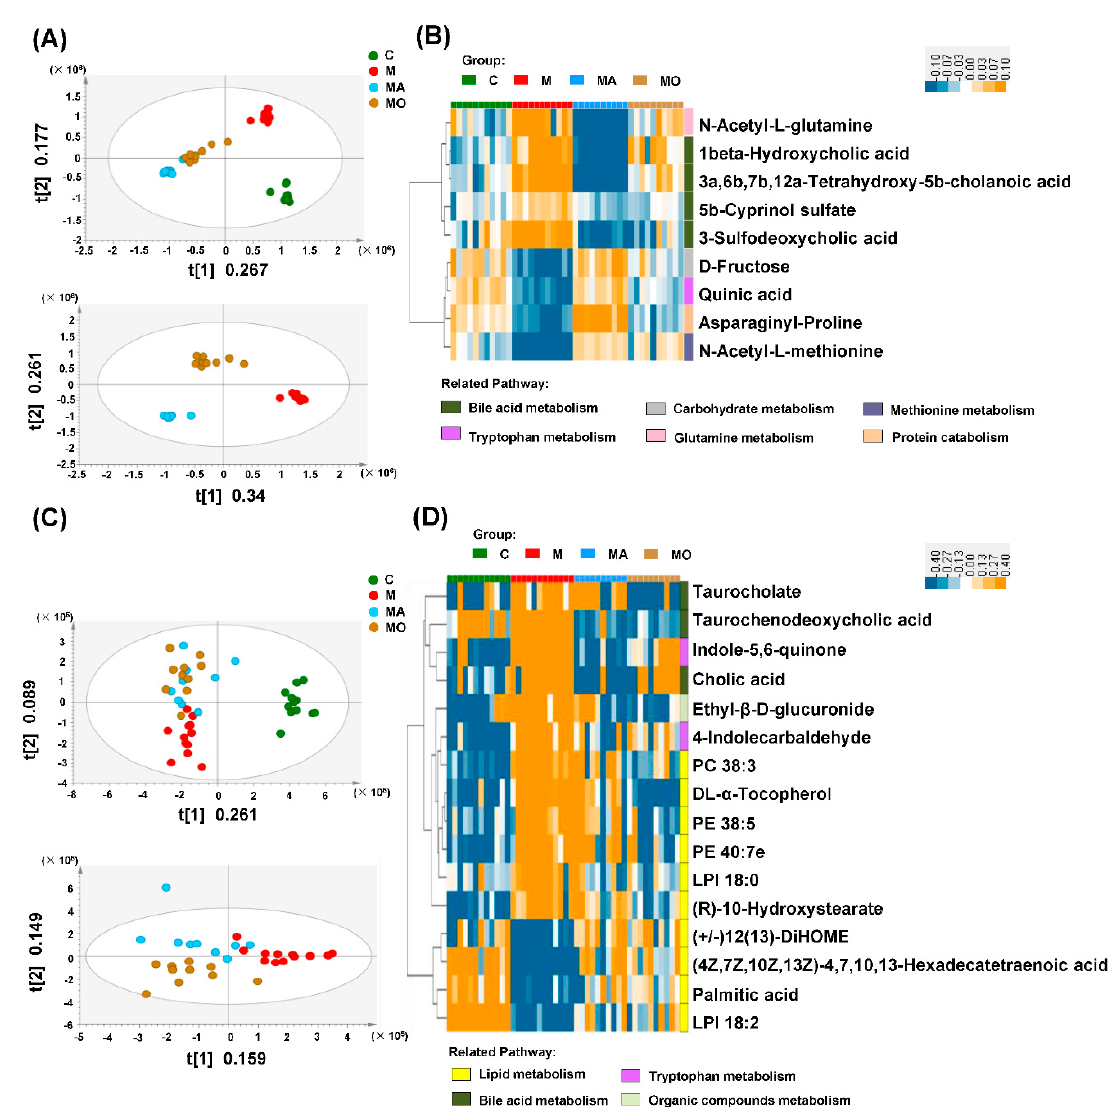
Figure 6. OCA supplementation improved gut microbiota-mediated metabolic disturbance in HFHS diet mice. The OCA supplementation reversed disordered fecal and serum metabolic profiles in HFHS diet mice, and the OCA-modified metabolites were also improved by ABX treatment. PLS-DA models based on data of ( A ) fecal and ( C ) serum metabolomics. The clustering heat map of the differential metabolites improved by OCA and ABX supplementation in ( B ) feces and ( D ) serum of HFHS diet mice. (The abscissa of the clustering heat map corresponds to the group, and the ordinate of different color modules corresponds to related pathways of metabolites. The colors from blue to orange indicate the relative concentration of serum metabolites in each sample). Note: n : ( A – D ) 10–12 per group. Groups: C, mice with normal chow; M, mice with HFHS diet; MA, ABX-treated HFHS diet mice; MO, OCA-treated HFHS diet mice. Abbreviations: HFHS, high-fat high-sugar; ABX, antibiotics; OCA, obeticholic acid; PLS-DA, partial least-squares-latent structure discriminate analysis; UHPLC, ultra-high-performance liquid chromatography; MS, mass spectrometry.